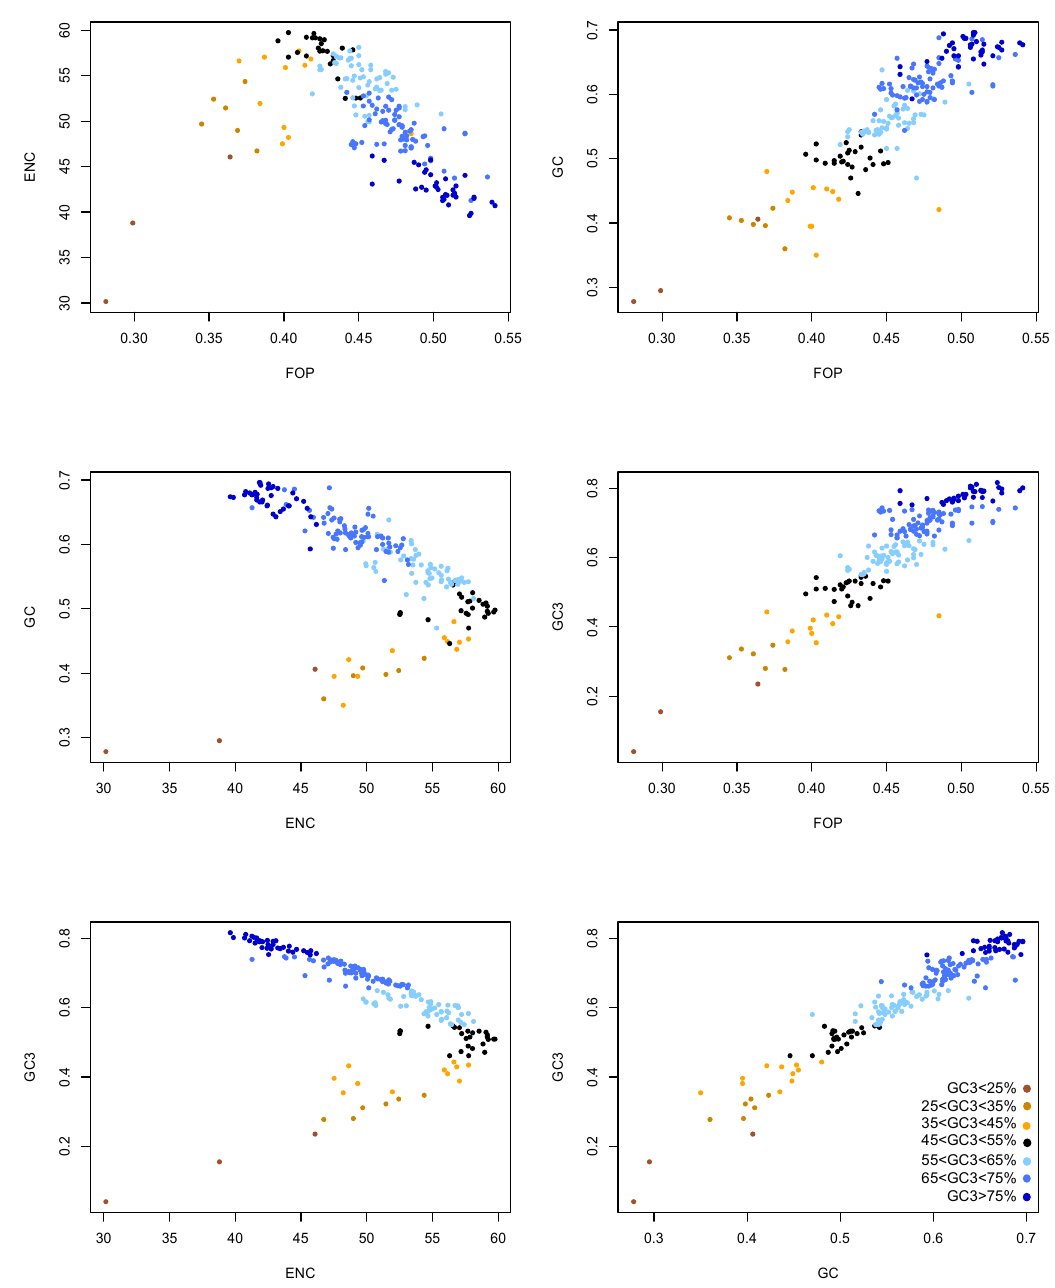
Figure 1. Correlation between codon usage bias and GC content across the phytoplankton species analysed. FOP, ENC, GC and GC3 are strongly correlated with each other, though the correlation is reversed for the species with AT-rich-preferred codons (orange and brown data points on the left three panels). All correlations are highly significant (Pearson correlation, p -value < 0.001). Original data are provided in Table S1.